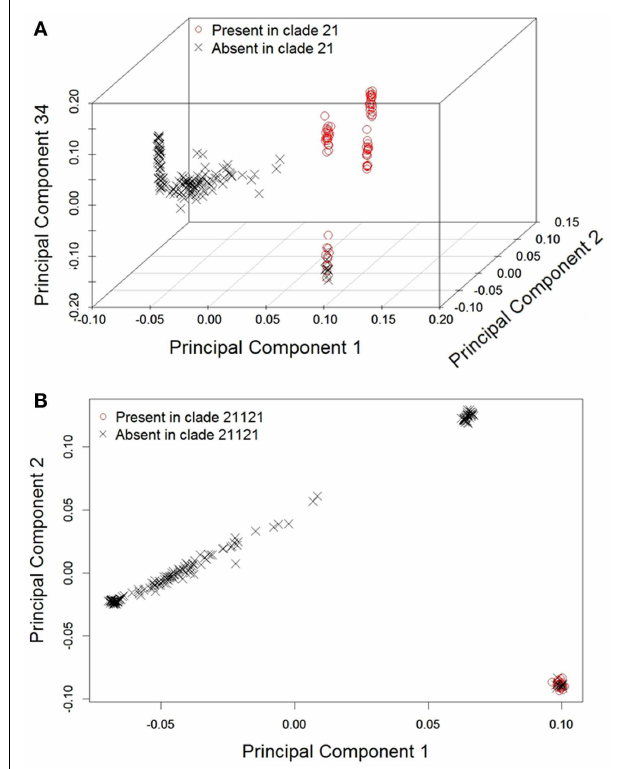
FIGURE 3 | Example plots depicting how principal component scores are associated with phylogeny: (A) 21 with principal components 1, 2, and 34 and (B) 21121 with principal components 1 and